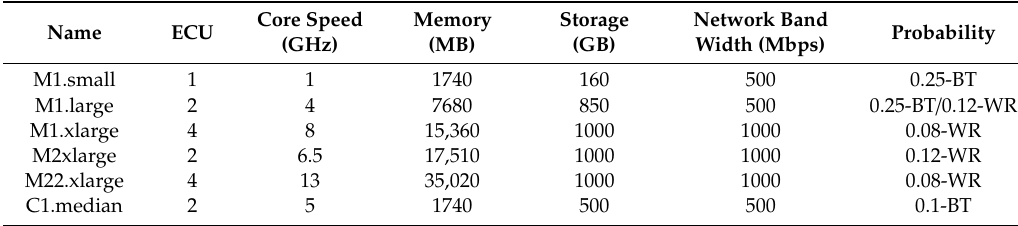
Table 3. Virtual machine request types